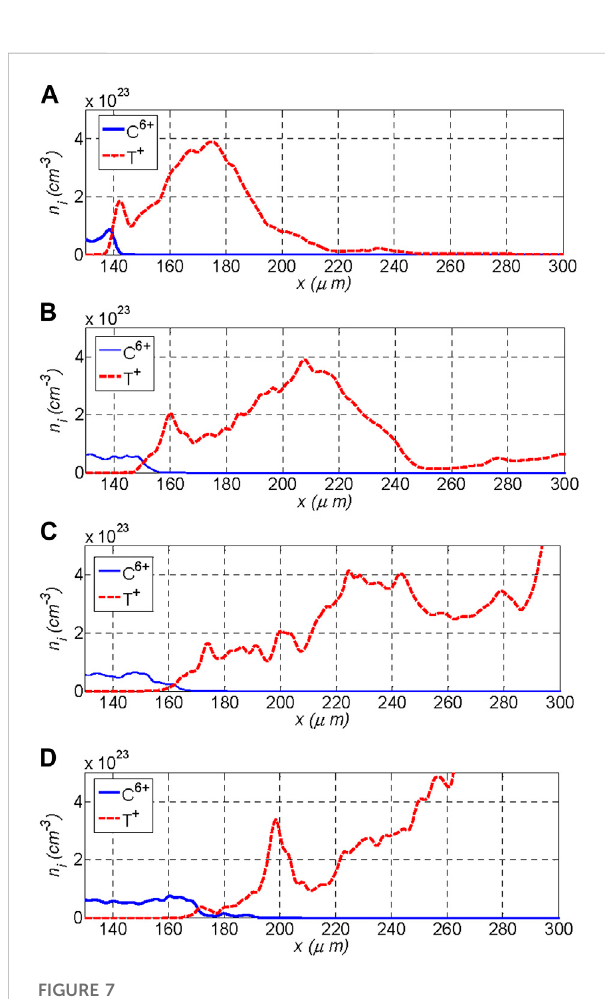
FIGURE 7 The slice of the ion density pro fi le of C 6+ /T + around the ablator- fuel interface at different times: (A) t = 2.32 ns, (B) t = 2.41 ns, (C) t = 2.49 ns, (D) t = 2.57